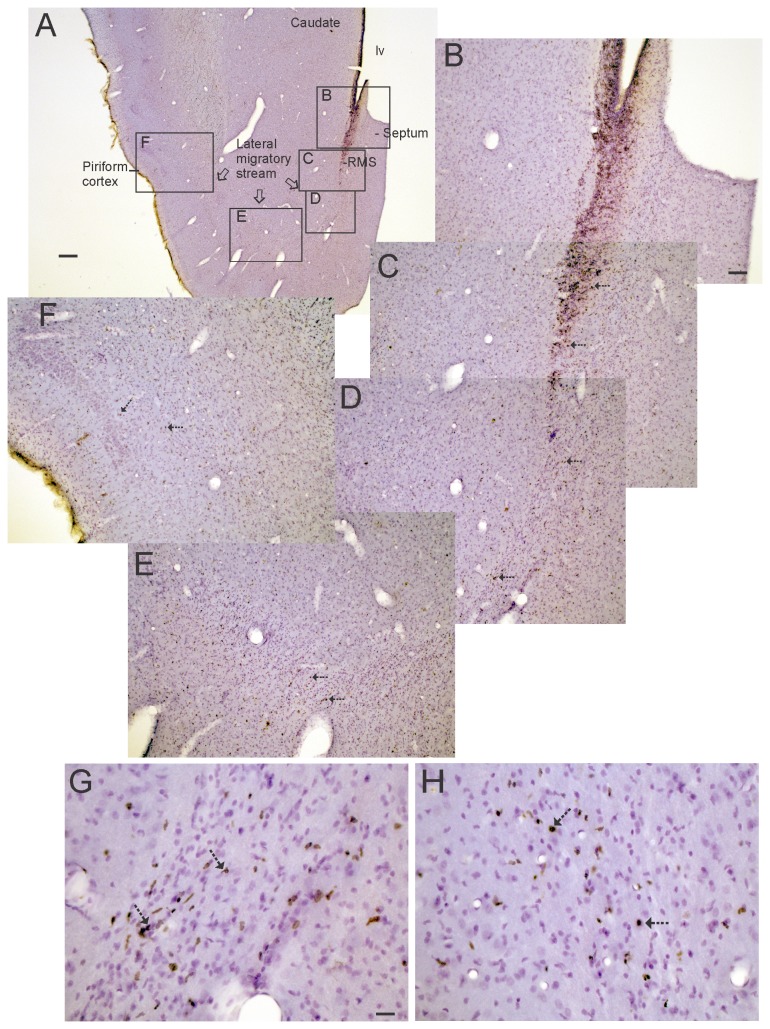
In vivo BrdU labeling in piglet forebrain reveals a new corridor of newly born cells named the lateral migratory stream.
A-H. Images of a piglet forebrain section are shown with BrdU incorporation detected by the immunoperoxidase method (brown labeling) and counterstaining with cresyl violet. A low magnification image of piglet ventral forebrain is shown for perspective (A). Regions delineated by black rectangles in A are shown as higher magnification montage images in B-F that illustrate the distributions of BrdU labeled cells (hatched arrows, brown dots). Rostral migratory stream (RMS), and lateral ventricle (lv).G and H. Higher magnification images showing BrdU+ cell labeling (hatched arrows, brown nuclei) in the lateral migratory stream (G) beneath the striatum and in the piriform cortex (H). Unlabeled nuclei are pale violet. Scale bars: A = 300 µm, B (same for C-F) = 100 µm, G (same for H) = 25 µm.